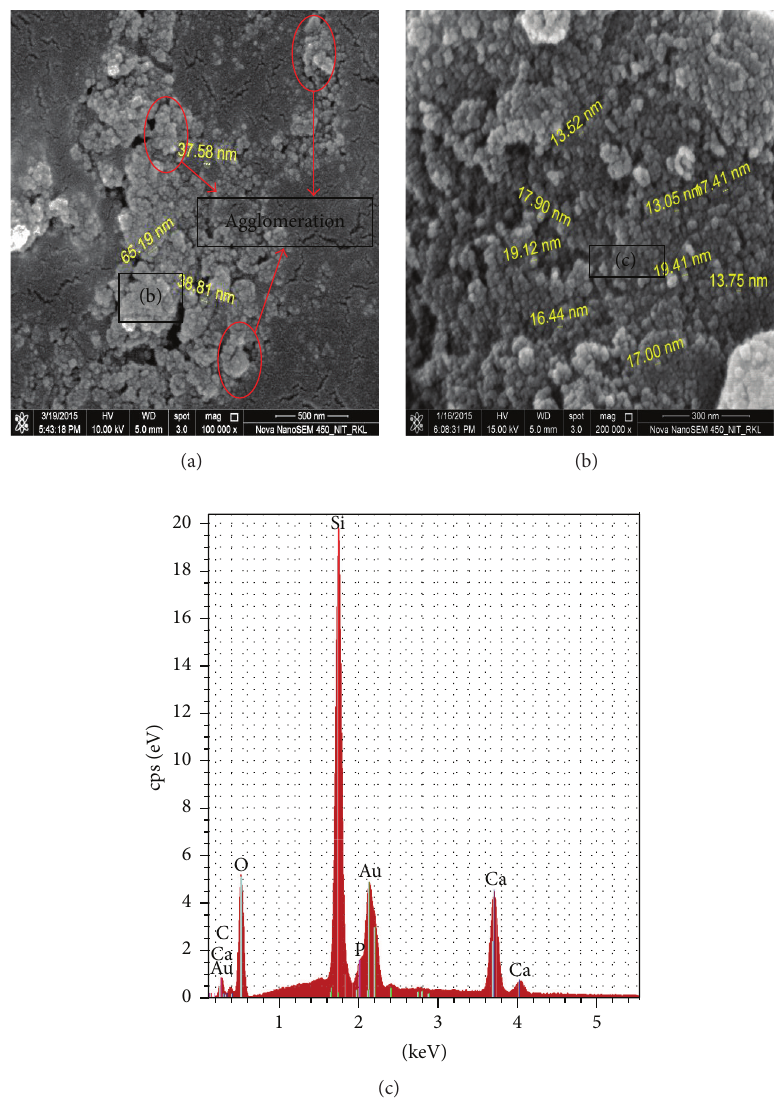
Figure 4: (a) FESSEM micrograph of synthesized bioglass nanopowders, (b) magnified image of particle agglomerate, and (c) elemental composition analysis of the synthesized bioglass nanoparticles.